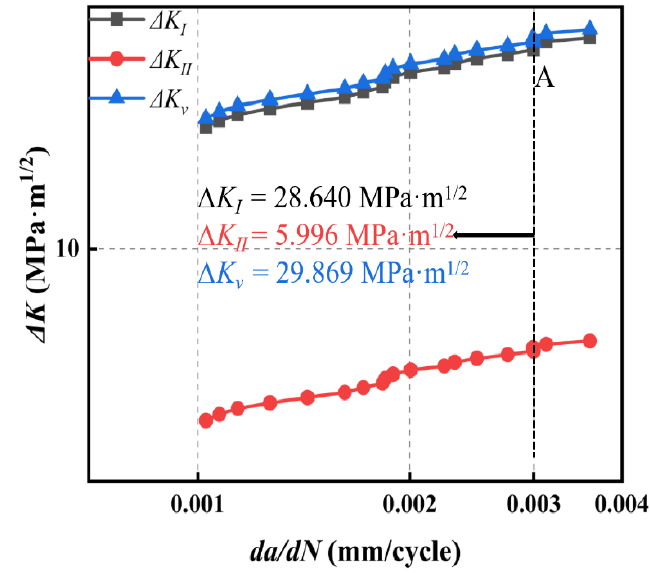
Figure 7. Wher e β = 60°, λ = 0, R = 0.1, the relationship between ∆ K I , ∆ K II and ∆ K v . Figure 7. Where β = 60 ◦ , λ = 0, R = 0.1, the relationship between ∆ K I , ∆ K II and ∆ K v . At point A, da / dN = 0.003 (mm/cycle), ∆ K I = 28.640 (MPa·m 1/2 ), ∆ K II = 5.996 (MPa·m 1/2 )